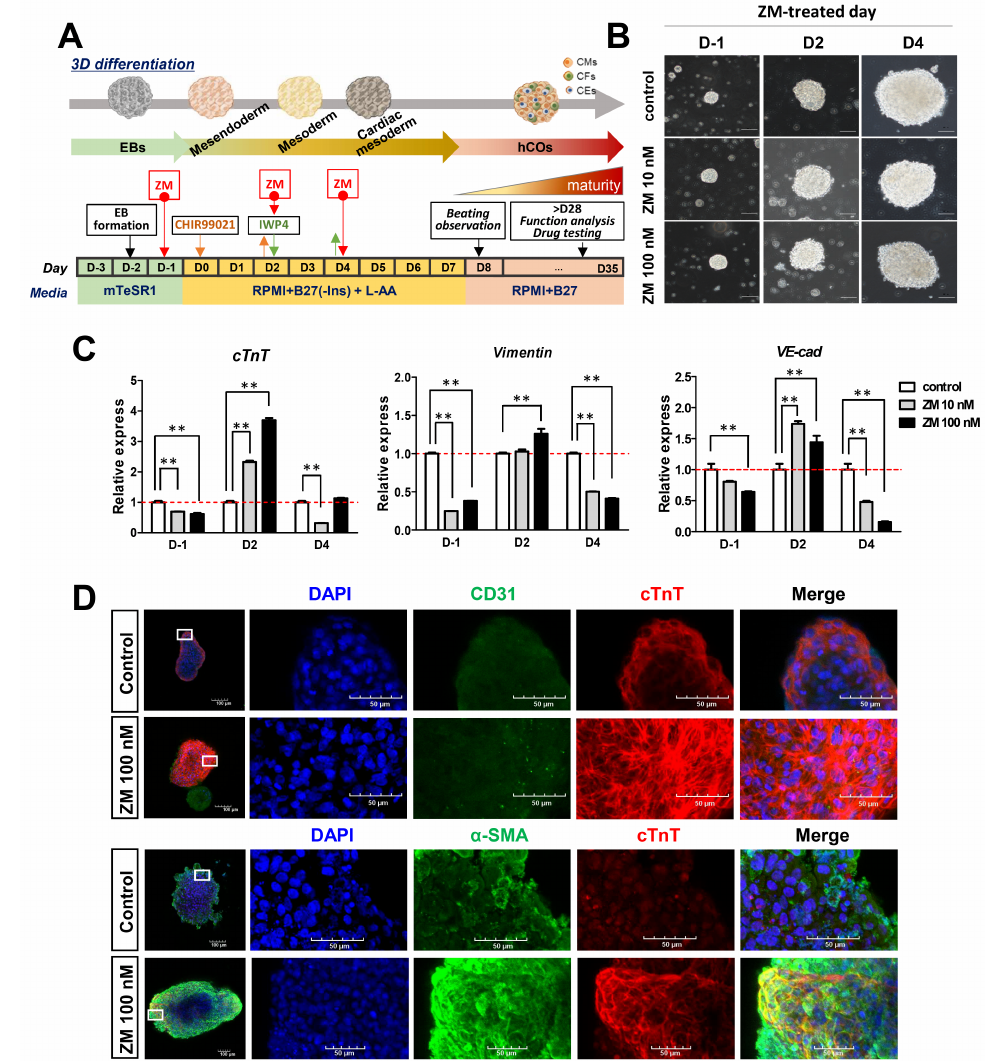
Figure 4. Effects of ZM447439 on the generation of iPSC-hCOs: ( A ) Protocol of hCOs treated with ZM447439. ( B ) Differentiation of 0, 10, or 100 nM ZM treated hCOs. Scale bar, 100 µ m. L-AA, L-ascorbic acid. ( C ) Gene expression of mesoderm markers during hCO differentiation normalized to GAPDH expression. Data are presented as the mean + SEM. ** p < 0.01, by Dunnett’s test. ( D ) Immunofluorescence to detect CD31 (endothelial marker, green) and cTnT (cardiomyocytes marker, red) (upper). α -SMA (fibroblast marker, green) and cTnT (lower) at